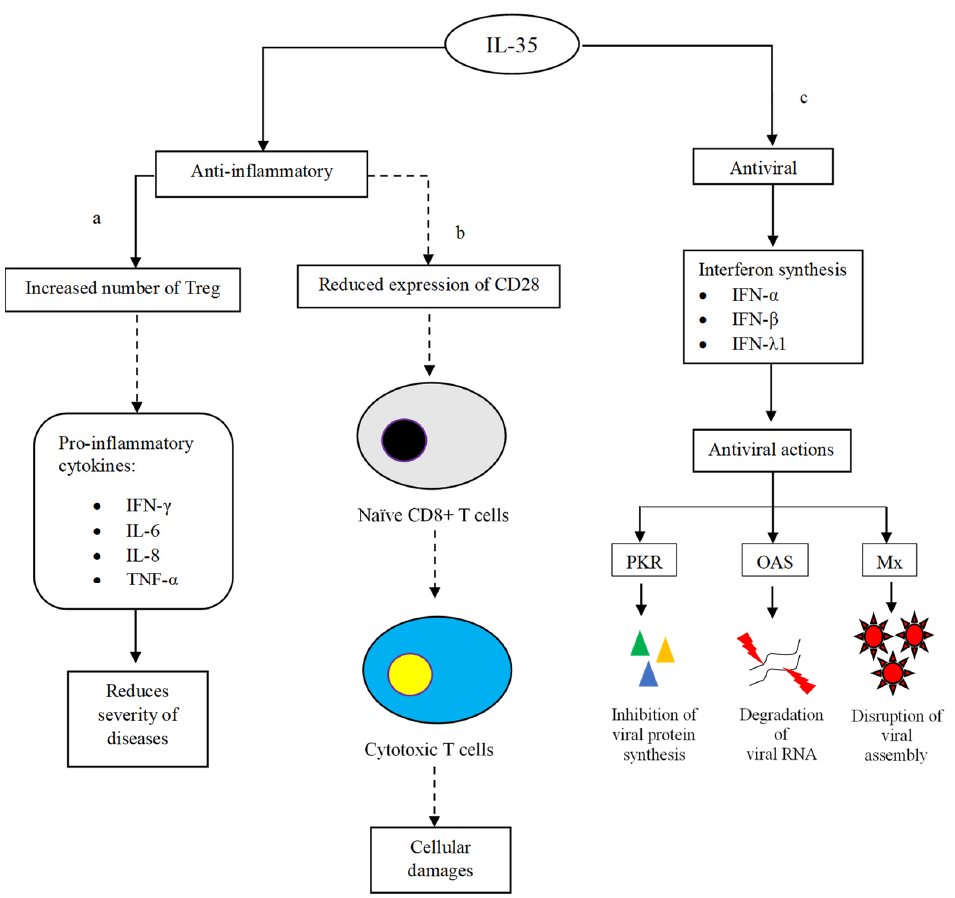
Figure 4. Anti-inflammatory and antiviral actions of IL-35. ( a ) IL-35 induces the proliferation of Treg in order to suppress the synthesis of pro-inflammatory cytokines. The inhibition subsequently improves inflammation and tissue damage that are usually manifested as the severity of virus infections. ( b ) IL-35 controls the maturation of naïve CD8+ T cells into cytotoxic T cells. The limiting number of mature cytotoxic T cells prevents the occurrence of cellular damage. ( c ) IL-35 induces antiviral effects via interferon production. Interferons are known to inhibit viral protein synthesis, genome replication and assembly. The inhibitory activities prevent virus replication and limit virus spreading. The dashed-line arrows represent inhibitory e ff ects.